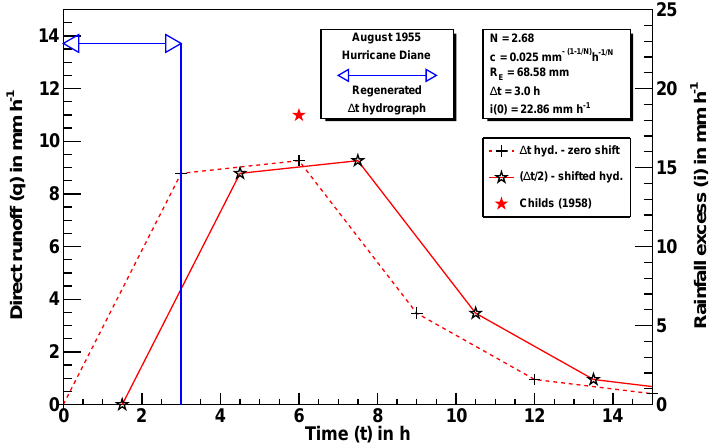
Fig. 8b. Same as Fig. 8a, except the 1t hydrograph is computed using the inverse Bakhmeteff function method of convolution.